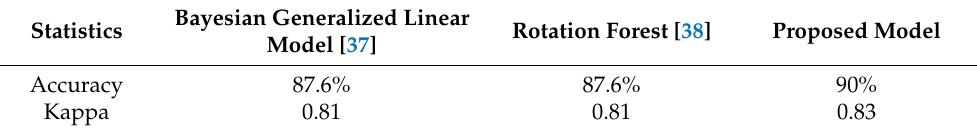
Table 5. Predictive analysis on the training